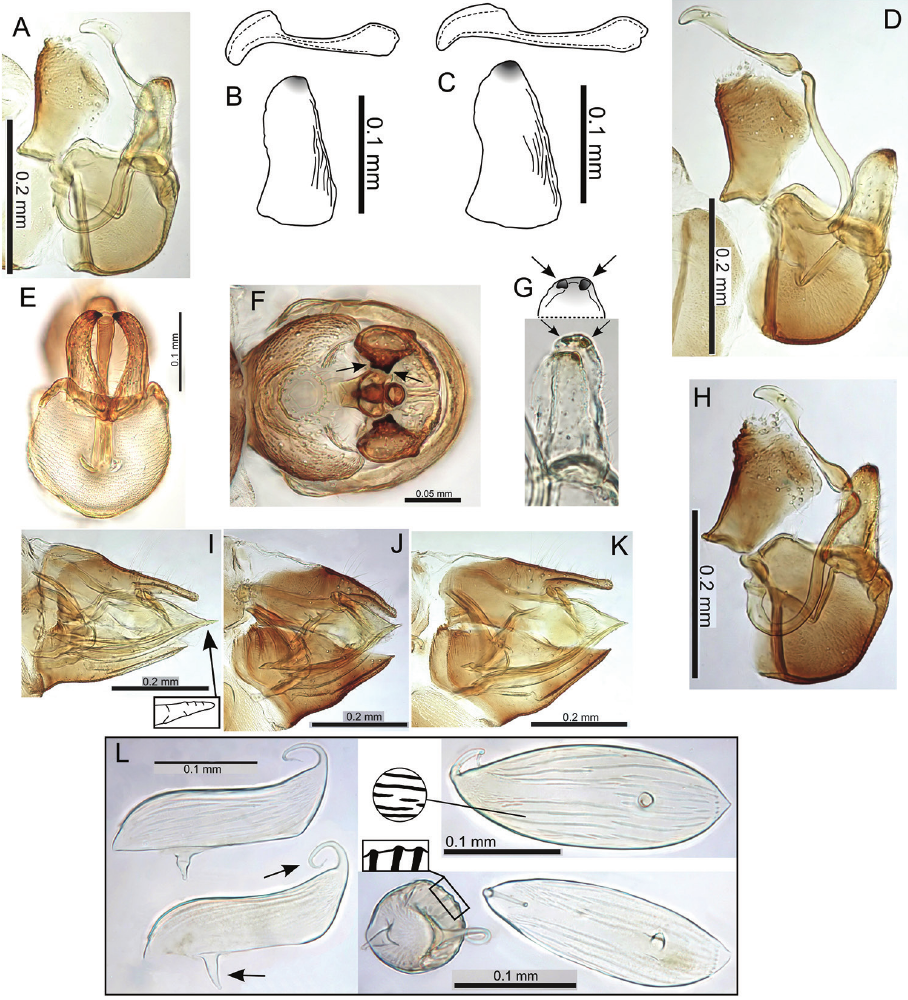
Figure 16. Pariaconus gracilis . A, B form gracilis (Aiea, Oahu): A male terminalia B aedeagus and paramere, C, D form gracilis (Molokai): C aedeagus and paramere D male terminalia E male terminalia (posterior view), form conconus (Koolau, Oahu) F, G form gracilis (Koolau, Oahu): F male terminalia (dorsal view, bipartite sclerotization indicated) G male paramere with interior view of paramere apex (bi- partite sclerotization indicated) H male terminalia, form gracilis (Maui) I, J form gracilis (Oahu): I female terminalia (ovipositor serrations indicated) (Koolau) J female terminalia (Waianae) K female terminalia, form gracilis (Molokai) L eggs (pedicel, tail, and striations indicated), form gracilis (Oahu).